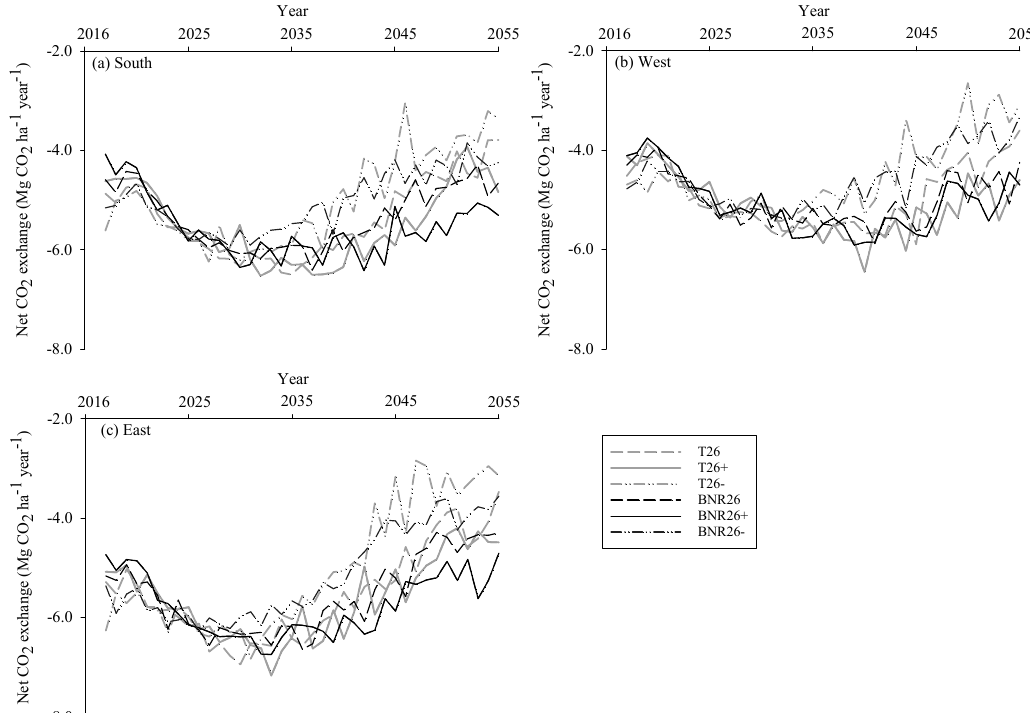
Figure 1. Annual net CO 2 exchange (Mg CO 2 ha − 1 year − 1 ) over the 40-year period for the baseline (T26) and some selected alternative management scenarios and harvest intensities in the final felling made at breast height diameter (DBH) of 26 cm in southern ( a ), western ( b ) and eastern ( c ) sub-regions of Finland. For the key of the management scenarios, see Table